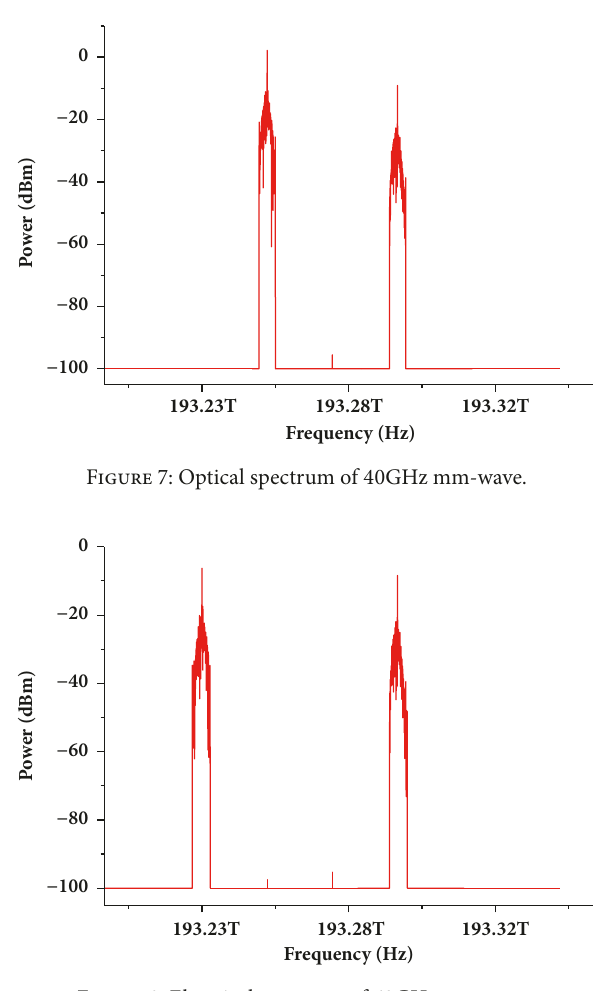
Figure 8: Electrical spectrum of 60GHz mm-wave.